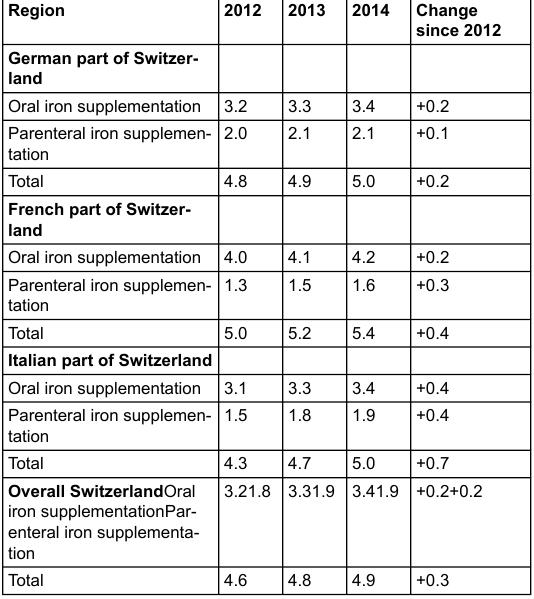
Table 2: Prevalence of oral and parenteral iron supplementation in Switzerland (percentage of insured people).